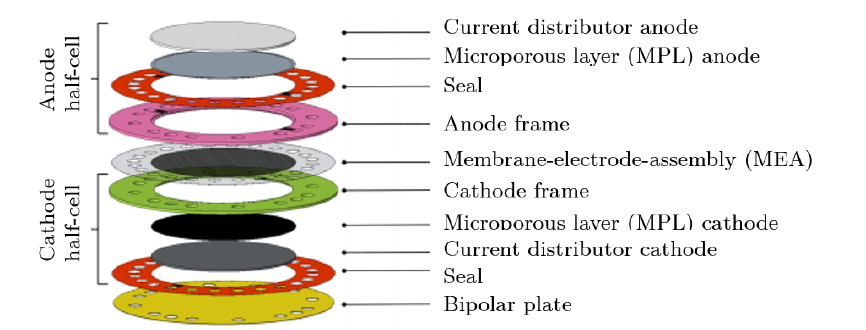
Figure 3. PEM cell